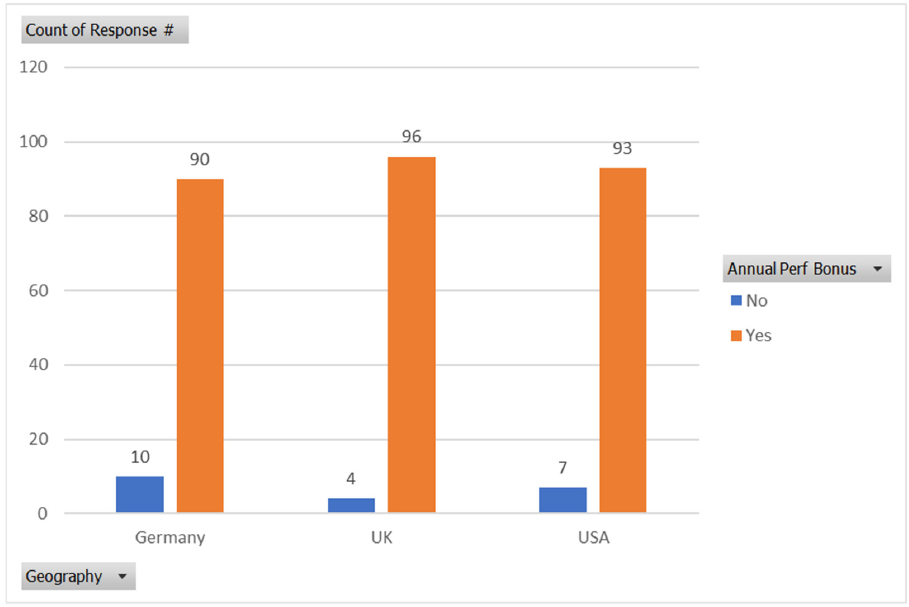
Figure 3. Existing bonus systems by country.